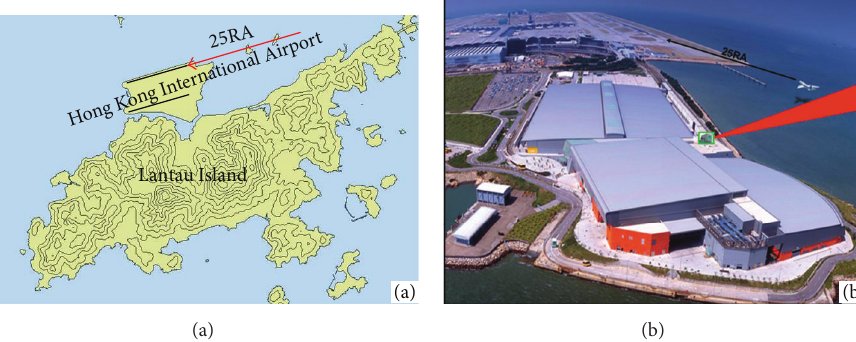
Figure 1: Hong Kong International Airport and the geographical situation nearby. (a) shows the Lantau Island that is near Hong Kong International Airport (height contours: every 100m). (b) is the diagrammatic sketch that shows the short-range LIDAR and its scan range (red sector) over Runway 25RA of Hong Kong International Airport from the roof of the